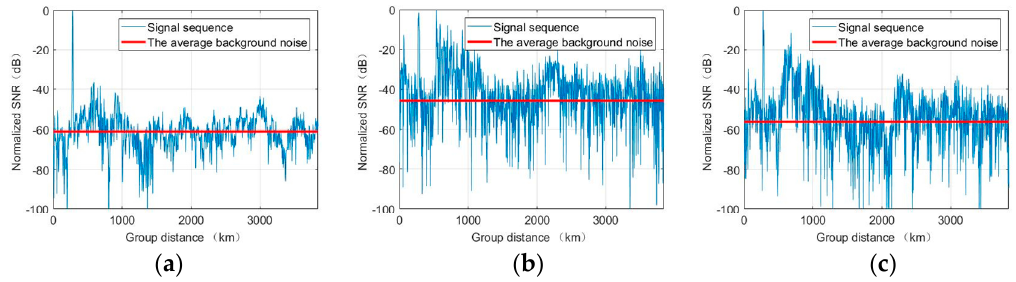
Figure 16. Normalized SNR of 6 MHz; ( a ) Channel 1; ( b ) SMI; ( c ) ESB.